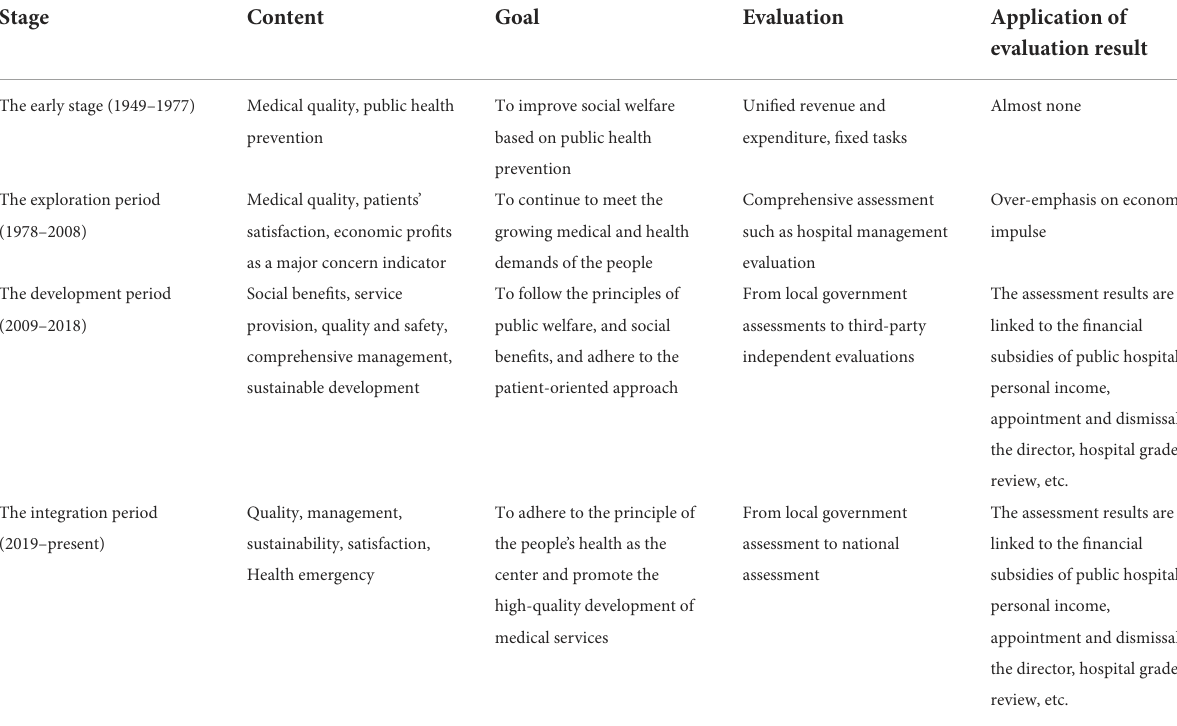
TABLE 1 Historical changes in performance assessment of public